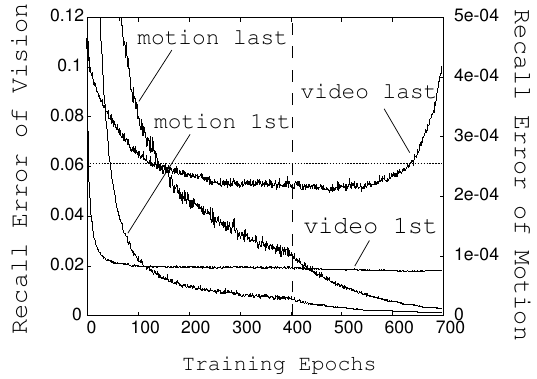
Figure 8: Recall errors during training of multi- modal LSTM autoencoder. The vertical dashed line indicates the epoch when learning rate annealing starts. The horizontal dashed line indicates the best recall error of the LSTM autoencoder for visual im-